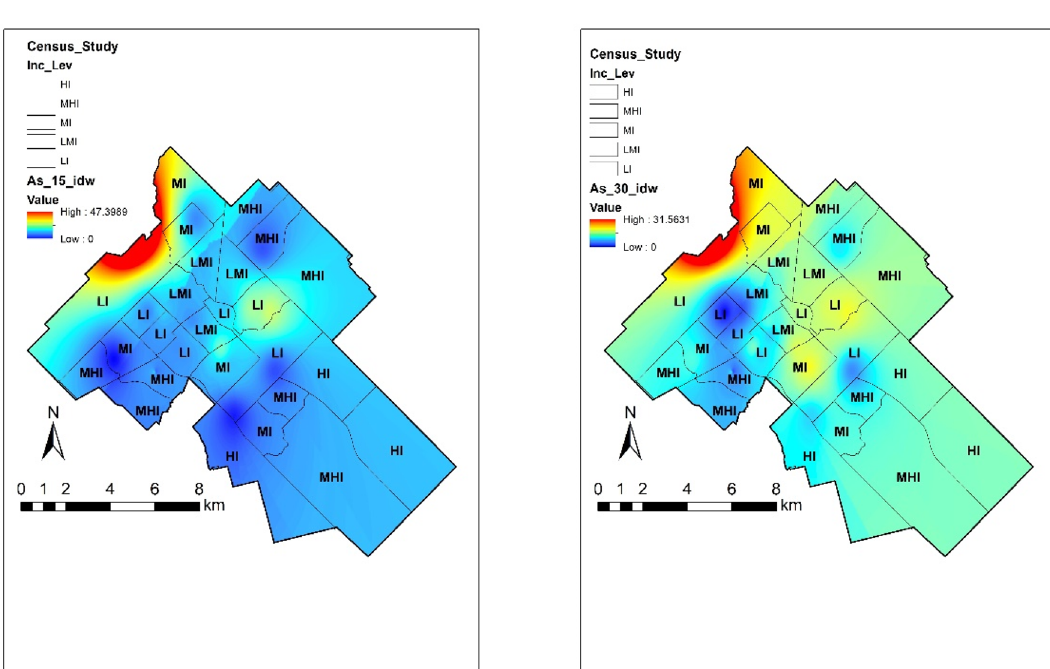
Figure 5. As concentrations across Guelph in two different depths and its association with low-income communities. The map was prepared by using the “Geostatistical Analyst” tool in ArcGIS 10.4 (https:// deskt op. arcgis. com/